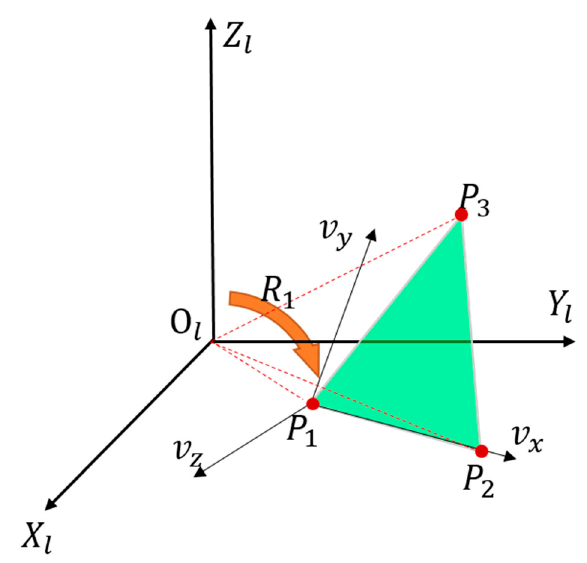
Figure 4. Schematic diagram of the three-point registration problem.